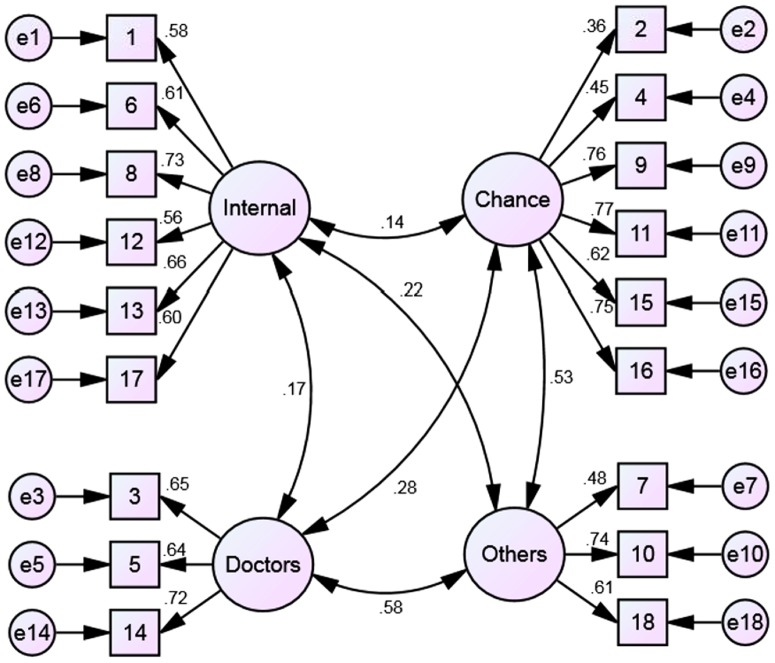
Structure of the MHLC Form C as hypothesized by the original test developers (displayed numbers are standardized regression weights in the present sample).